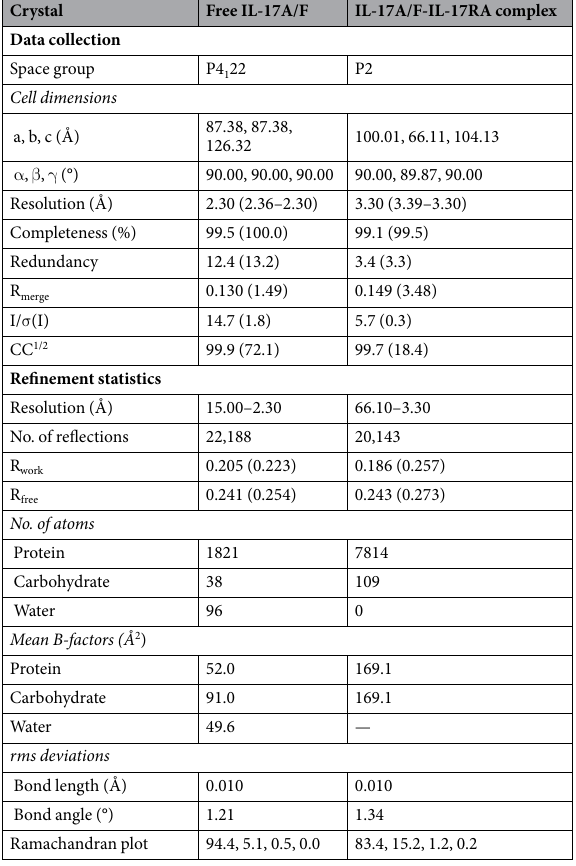
Table 1. X-ray data collection and refinement statistics. Values in parentheses are for the highest resolution shell; values for the Ramachandran plot correspond to most favorable, allowed, generously allowed and disallowed